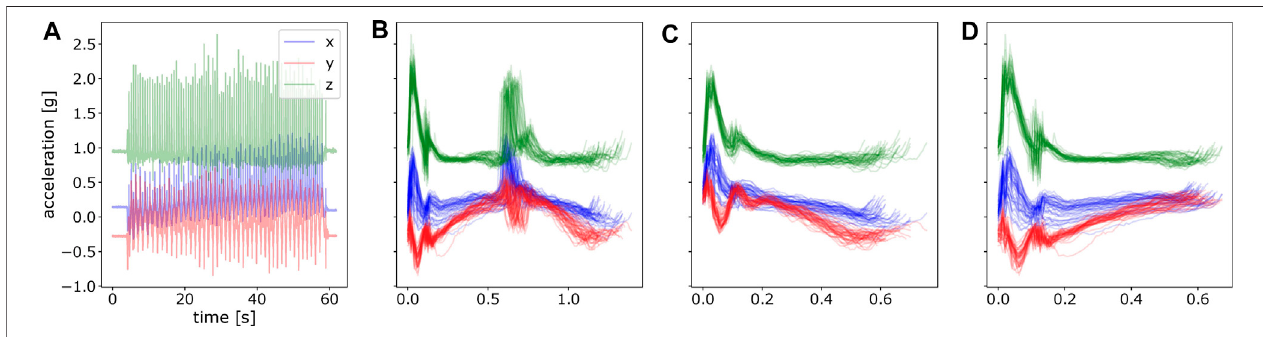
FIGURE4| Anillustrationofrawaccelerationpro fi leandsegmenteddata. (A) Rawhandaccelerationpro fi leofarandomsubjectinoneexperiment. (B) Segmented data for a complete movement from the touching pad 1 to the pad 2 and again to pad 1, concatenating both inward movements and outward movements. (C) Segmented motion from the pad 1 to the pad 2, namely, inward movements. (D) Segmented motion from the pad 2 to the pad 1, outward movements.